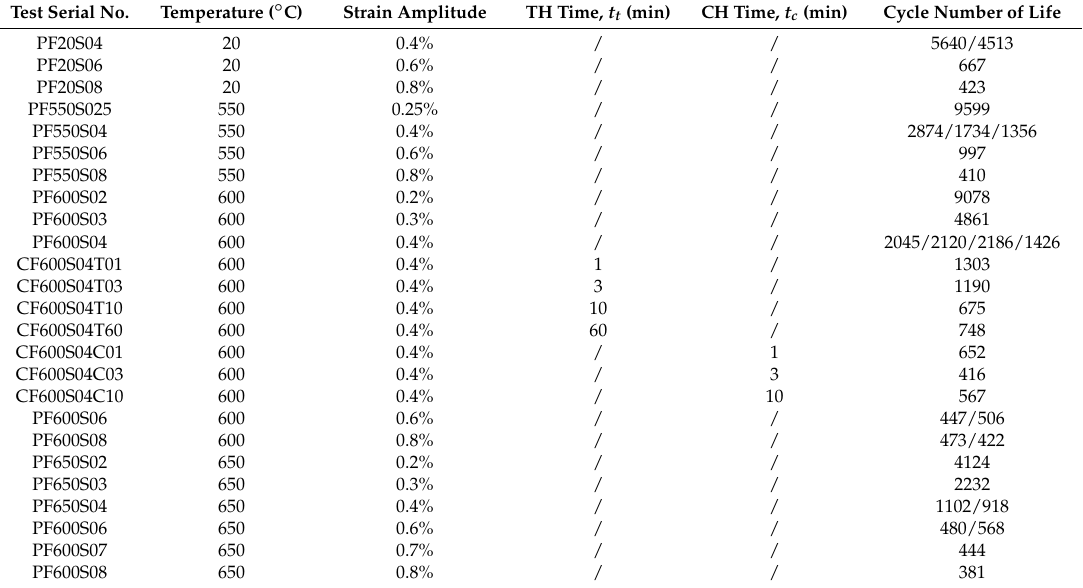
Table 1. LCF and CFI test data for P92